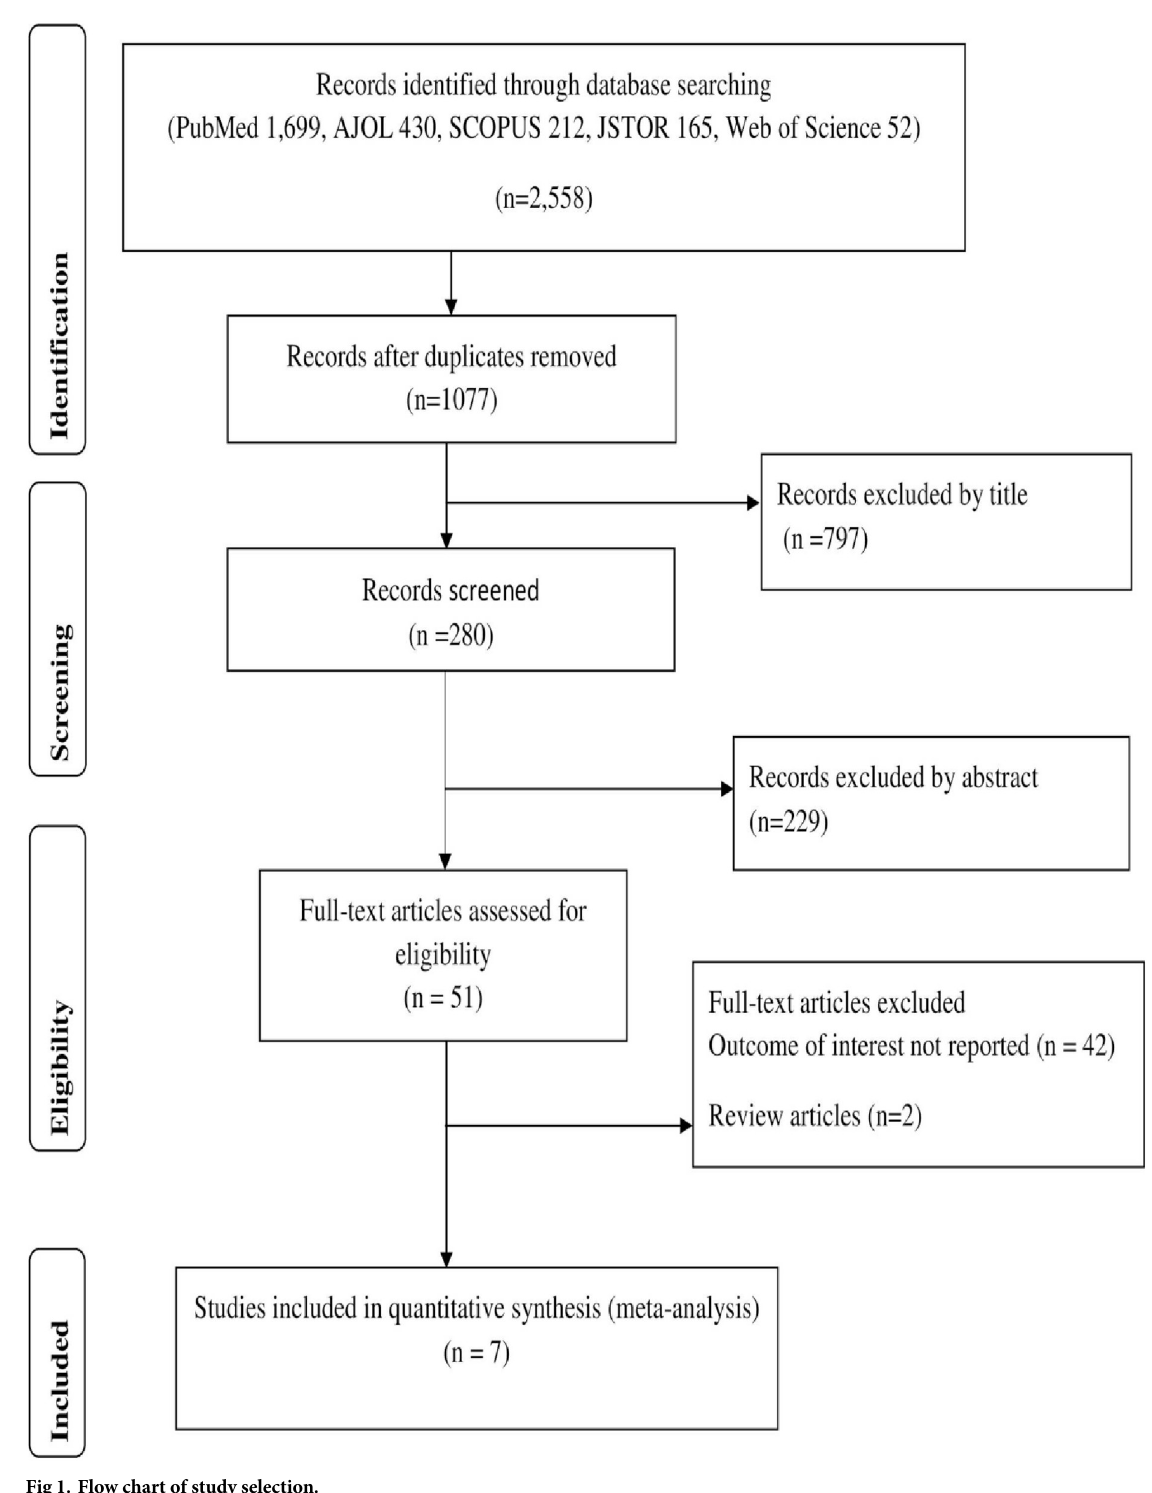
Fig 1. Flow chart of study selection.